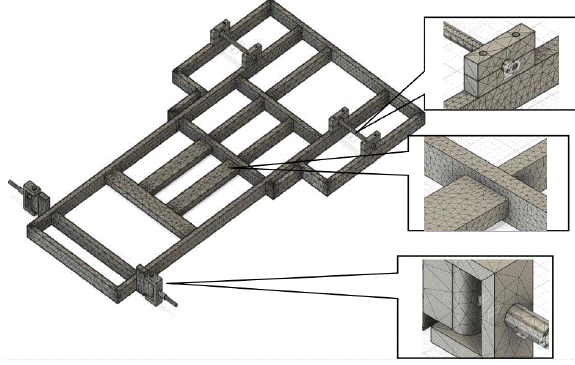
Figure 8: Meshing on the SEM urban vehicle frame design